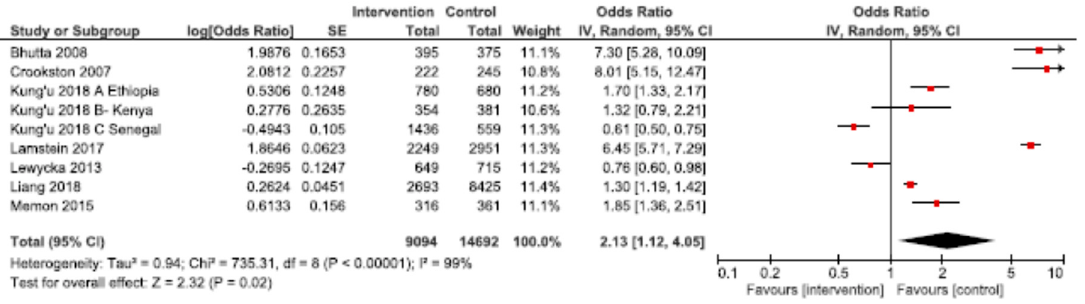
Figure 6. Forest plot of the meta-analysis of early initiation of breastfeeding for home visits and mother/peer groups.